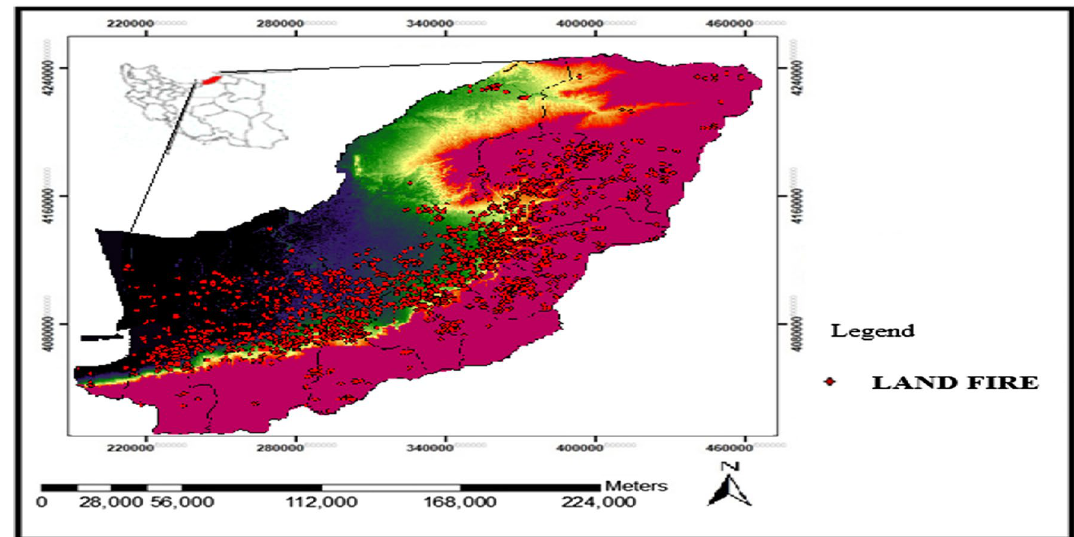
Fig. 1 Geographical location of Golestan province in the country and location of the fire